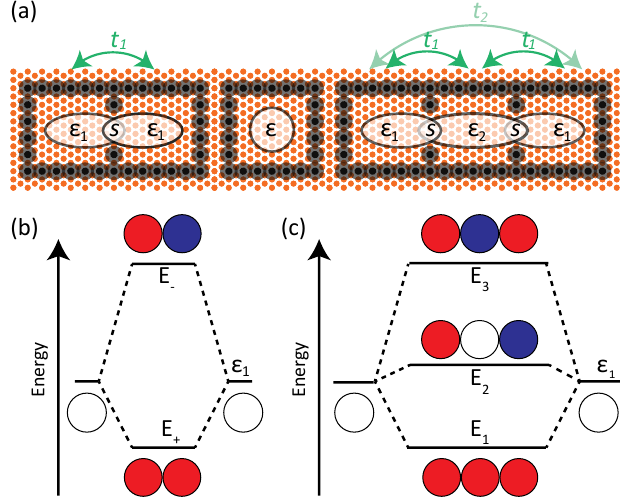
Figure 2: Coupling quantum corrals. (a) Example placements of CO molecules (black) on Cu(111) (orange) to produce a dimer, a lone corral and a trimer. White ovals roughly represent the spatial extent of the wave functions of the individual quantum corrals. (b) and (c) show the molecular orbital diagrams for a dimer and a trimer, respectively. Red represents a positive value of the wavefunction and blue